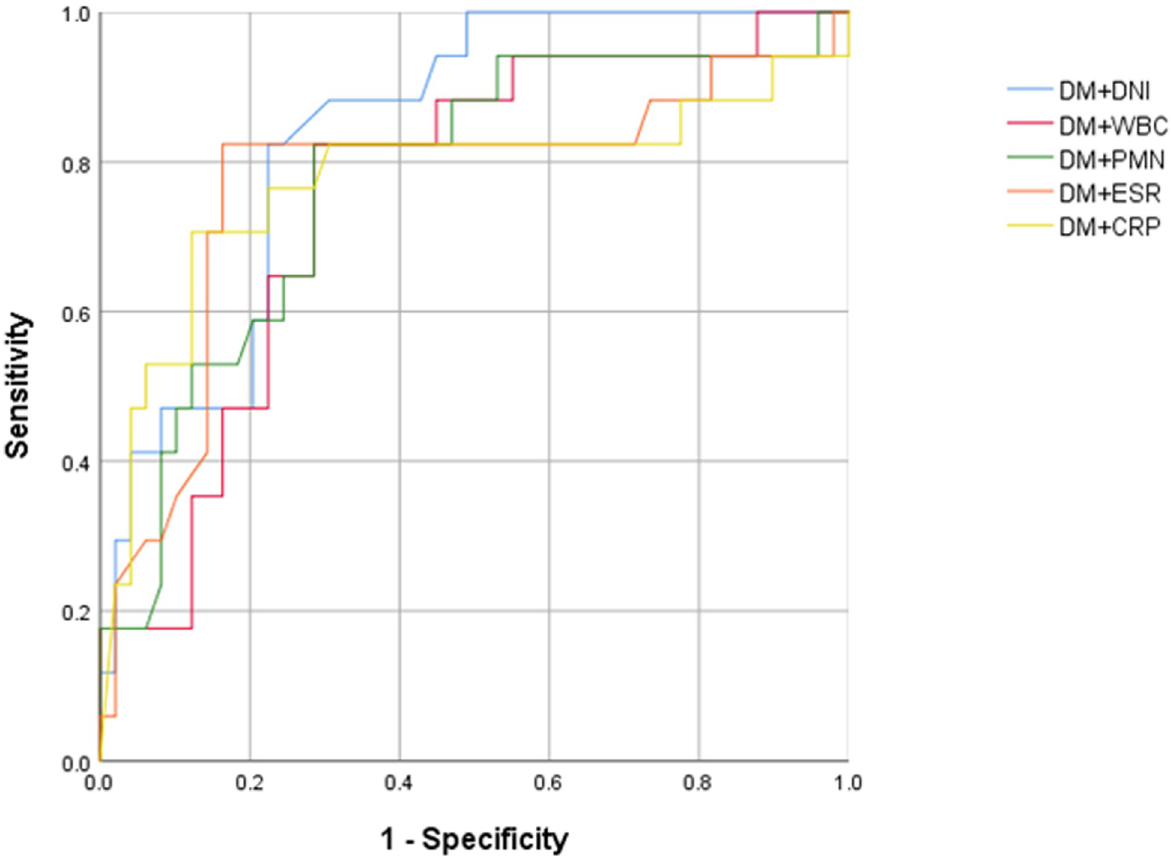
Fig 2. ROC curves of inflammatory biomarkers combined with DM for predicting surgery in patients with foot and ankle infection (DM, diabetes mellitus; DNI, delta neutrophil index; WBC, white blood cell; PMN, polymorphonuclear leukocyte; ESR, erythrocyte sedimentation rate; CRP, C-reactive